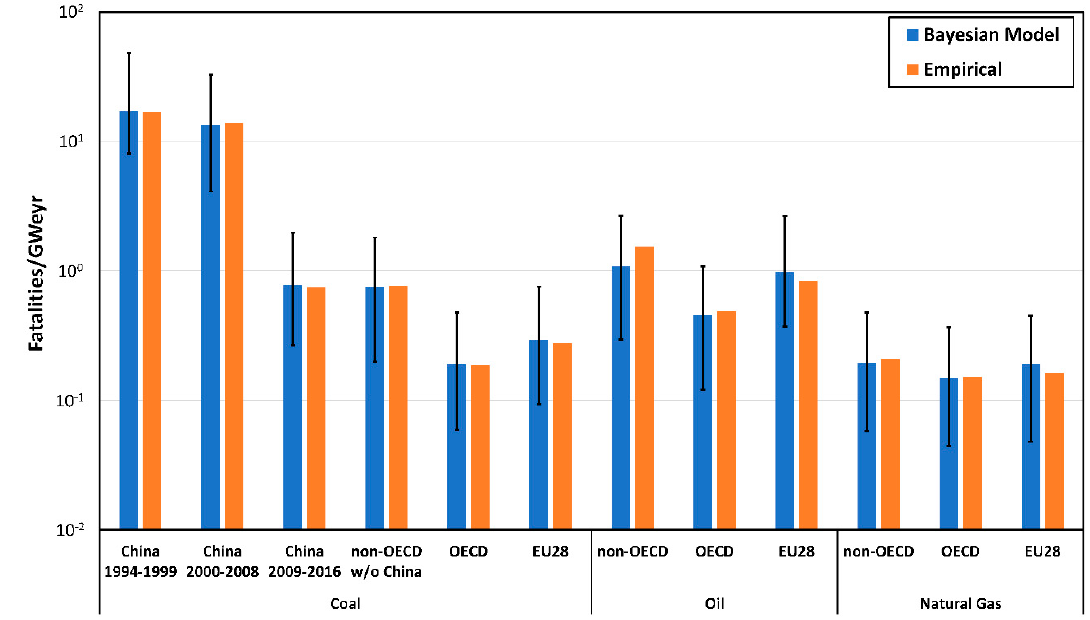
Figure 3. Risk for the Expected Scenario in terms of fatalities per GWeyr modelled using a BMA and an empirical approach.